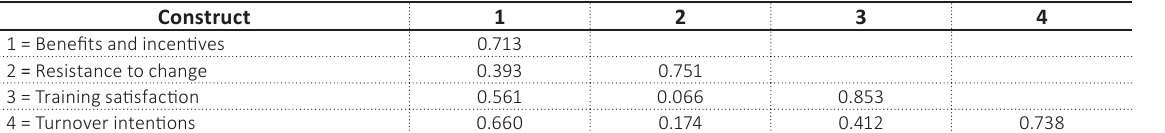
Table 6. Hypothetical path coefficient